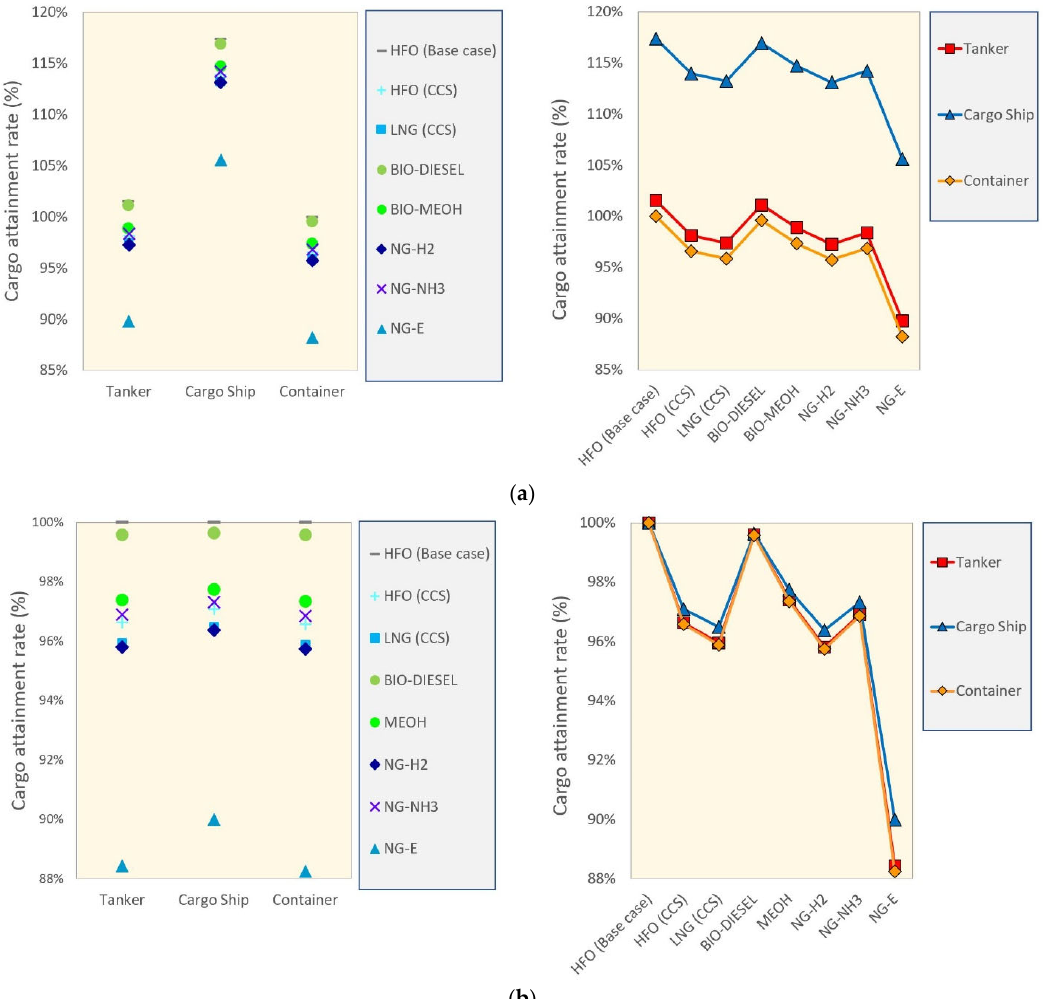
Figure 5. Cargo attainment rate (%) for various ship types and alternative fuels, for a stowage fac ‐ tor of 1.25 m 3 /ton and a voyage length of 10,000 nm, ( a ) when the reference ship is HFO ‐ fuelled containership is used, and ( b ) when same type of ship powered by HFO is used as reference ship, i.e., HFO ‐ fuelled containership, HFO ‐ fuelled tanker, and HFO ‐ fuelled cargo ship.